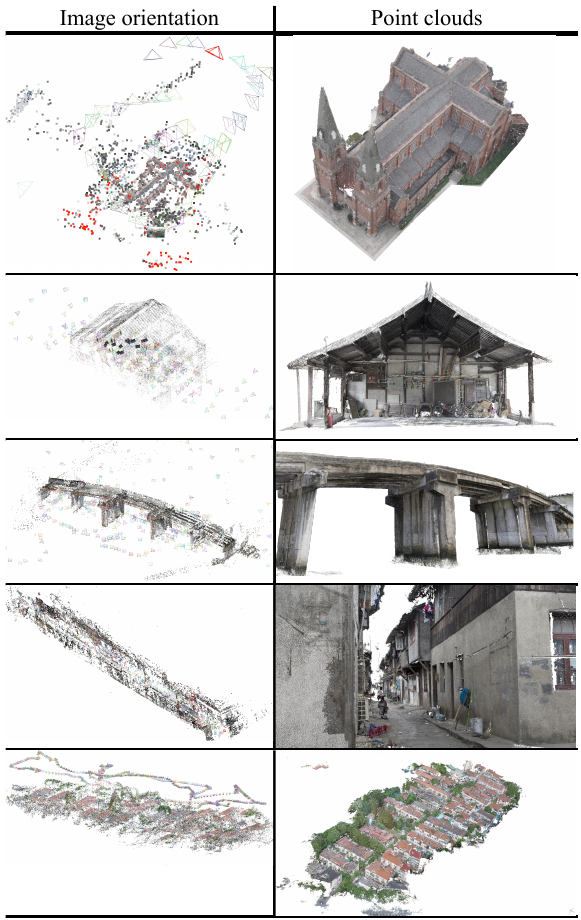
Figure 1. Low-cost digital survey techniques versatile to various types of